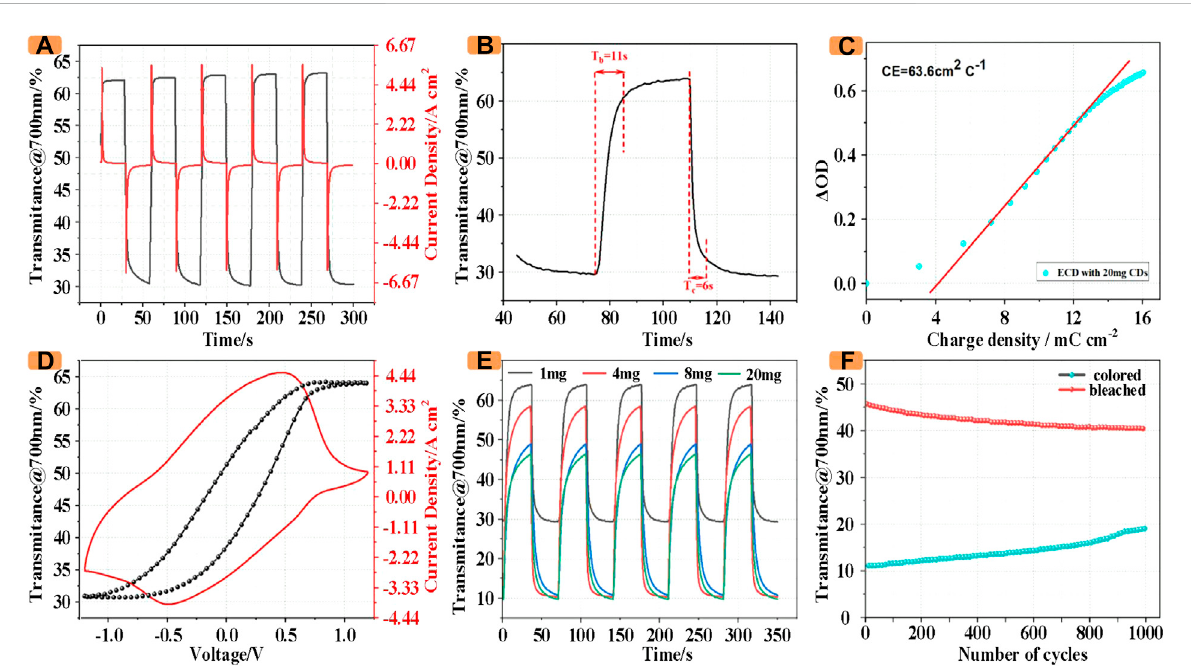
FIGURE 5 (A) CA and in-situ transmittance pro fi le. (B) Response time for the switching between coloration and bleaching states. (C) Optical density vs. charge density curve. (D) CV and in-situ transmittance pro fi le. (E) Transmittance of ECDs with different masses of CDs (F) Optical stability of 1,000 cycles at 700